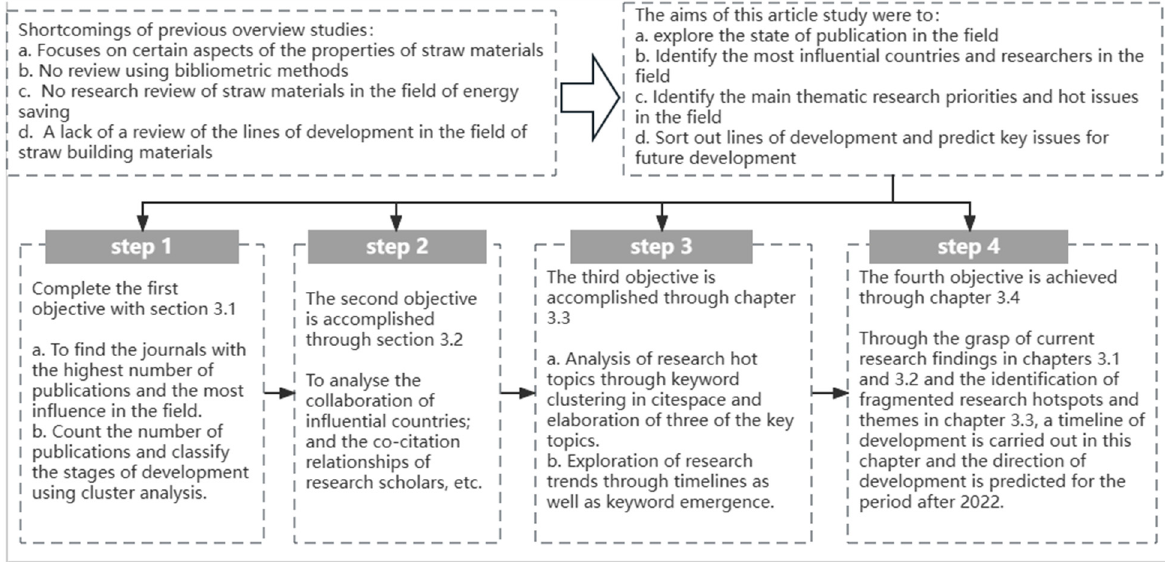
Figure 2. Logic diagram of the paper.